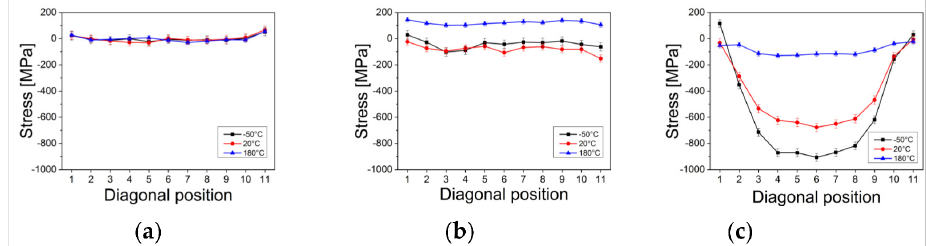
Figure 10. Stress distribution along the diagonal recorded at − 50 (Black points and lines), 20 (Red points and lines) and 180 ◦ C (Blue points and lines), on the Si_Unmounted chip ( a ), the A_AuSn_p sample ( b ) and the A_AuSn sample ( c ). Position i refers to the position [x, x] of Figure